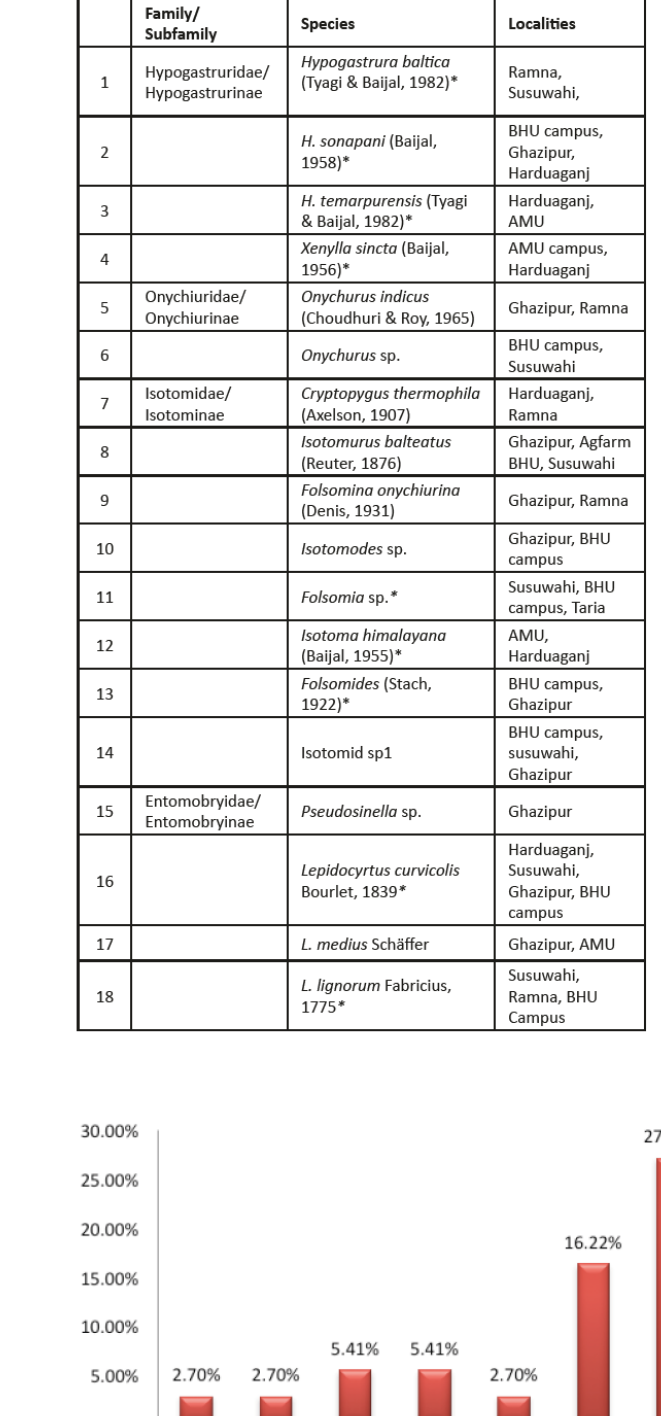
Ffigure 2. Percenttage occurrence off dfifferentt ffamfilfies/subffamfilfies off Collembola fin Uttar Pradesh,